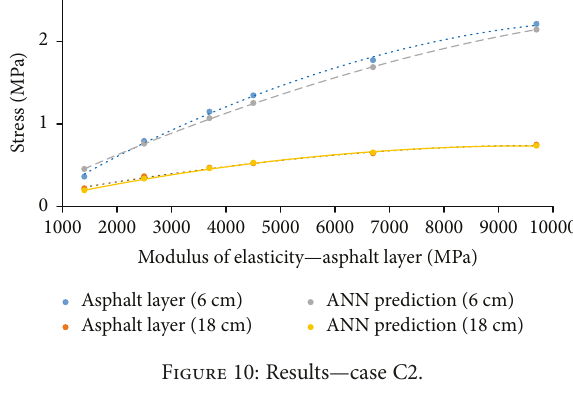
Figure 10: Results — case C2.